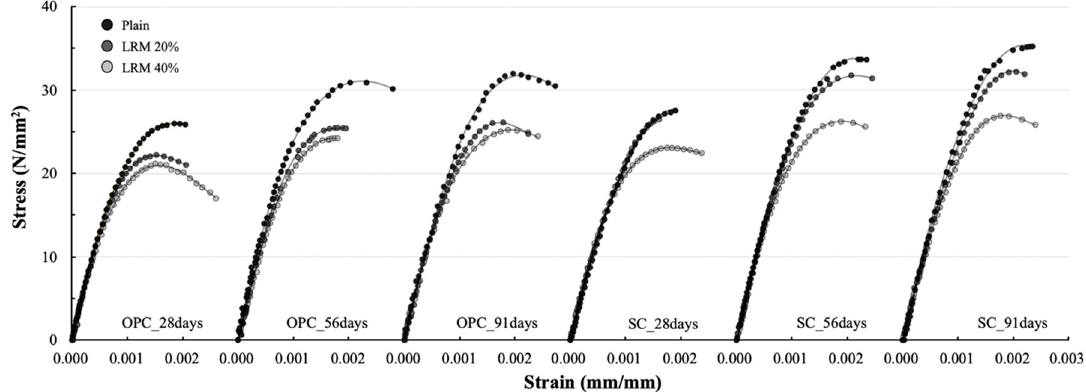
Figure 13. SSCs of LRM concrete for di ff erent cement Figure 13. (SSCs of LRM concrete for different cement types.